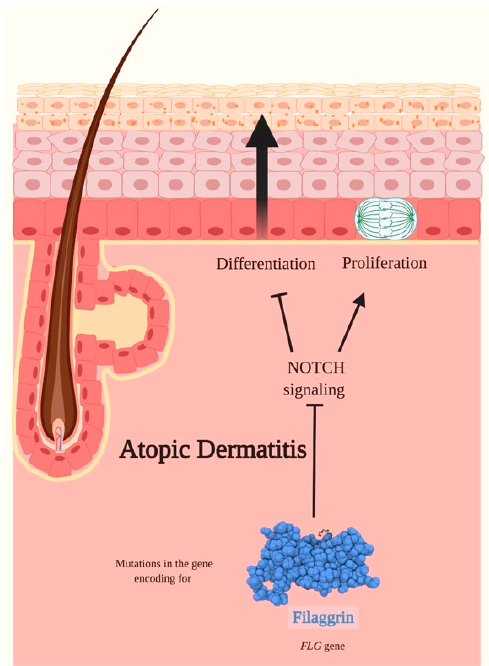
Figure 9. Atopic Dermatitis and Notch signaling. Atopic Dermatitis (AD) is a common, chronic and pruritic inflammatory disease. The pathogenesis of AD is multifactorial and occurs through a combination of disturbed epidermal di ff erentiation with abnormalities in the skin barrier functions, immune dysregulation, and genetic and environmental factors. Mutations in the FLG gene encoding for filaggrin have been registered to be the most common variants in AD familial forms. Filaggrin is a late epidermal di ff erentiation protein that possesses a high keratin-binding a ffi nity, interacts exclusively with intermediate filaments to form highly insoluble keratin sca ff olds necessary to guarantee the progressive di ff erentiation of keratinocytes and ultimately form the skin barrier. Loss-of-function mutations in the FLG gene are common in AD and cause a loss of filaggrin expression and therefore to a disturbed epidermal di ff erentiation. Notch signaling is required for the late-stage granular layer di ff erentiation and correct filaggrin processing in the epidermis. A downregulation of Notch receptors expression has been identified in lesional skin of AD. The inactivation of Notch receptors seems to promote the proliferation of epidermal cells leading, amongst other manifestations, to hyperkeratosis and to impair the correct di ff erentiation program in keratinocytes. Pointed arrows ( → ) define the induction of the indicated process or associated function, while the truncated arrow (T) designates the inhibition of the described process.